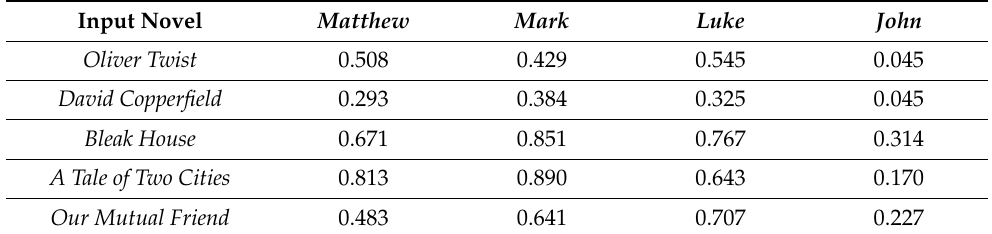
Table 14. Likeness index I L = I C between the indicated Dickens novels and the four Canonical Gospels in the King James translation (output), sentences channel. The Gospel in the first line indicates the output text; the text in the first column indicates the input text (regression line given in Table 10). For example, in the channel Our Mutual Friend → Bleak House , I L = 0.675, while in the reverse channel, Bleak House → Our Mutual Friend , I L = 0.724.